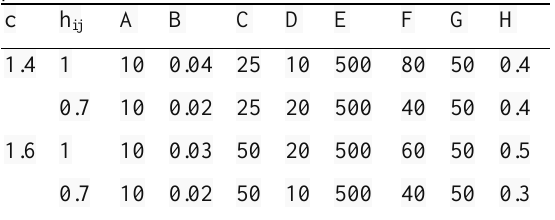
Table 5. Selected test problems and determined